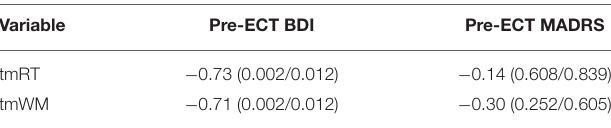
TABLE 3A | Significant correlations between threat modulation indices and BDI scores pre-ECT. Variable